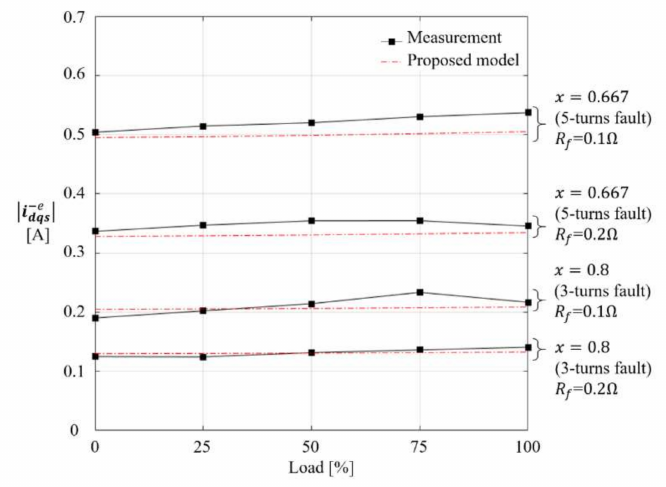
Figure 10. Comparison results of the negative sequence current between simulations and experiments under the various load conditions.